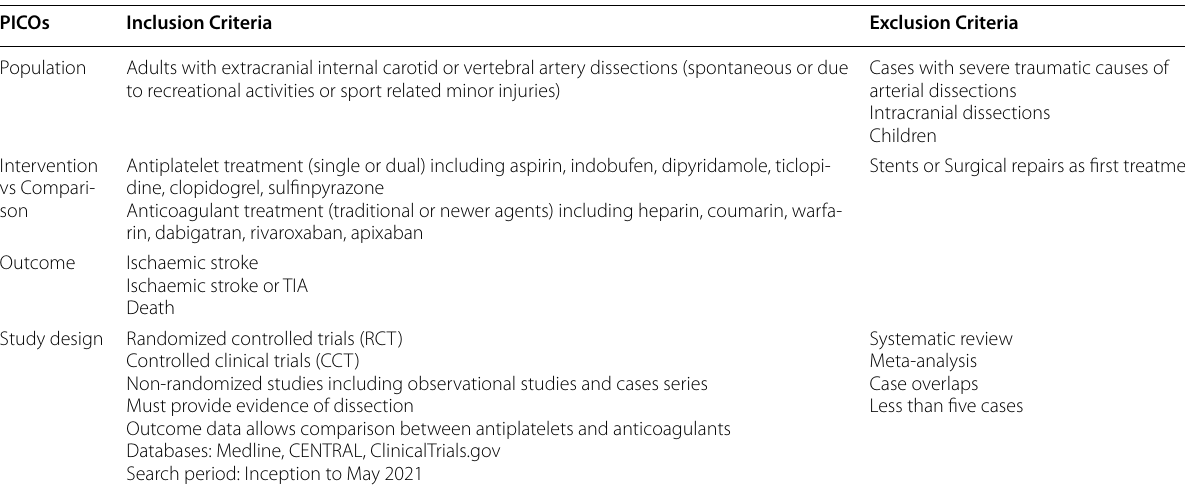
Table 1 PICOs framework and applied inclusion and exclusion criteria